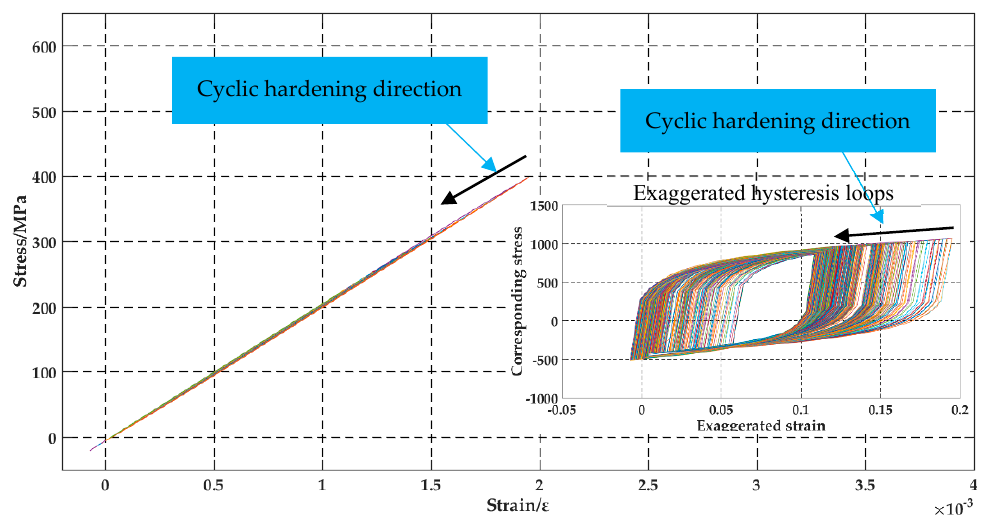
Figure 13. Strain stress response curve ("strain decline" phase for testing point 3#).